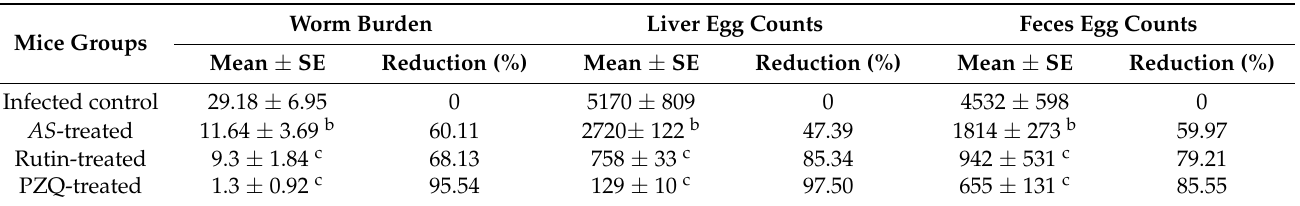
Table 3. Effect of different treatments on parasitological parameters of S. mansoni -infected CD1 mice. Mice